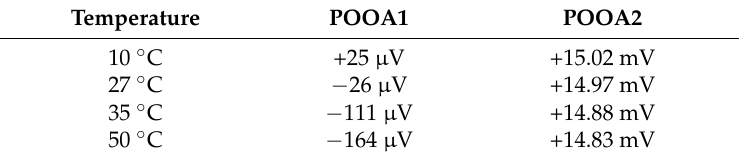
Table 3. Experimental results of the offset voltage of POOA1 and POOA2 at various